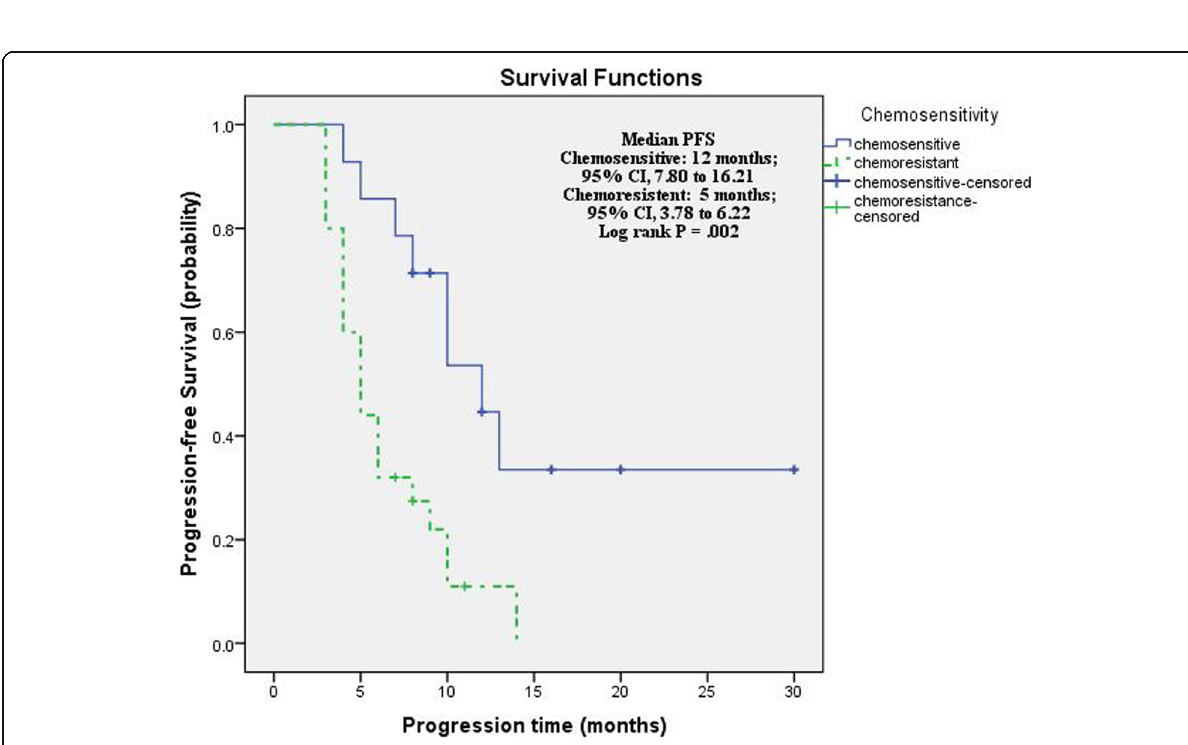
Fig. 3 Kaplan-Meier plot: progression-free survival according to chemosensitivity to prior anthracycline. CI confidence interval, PFS progression-free